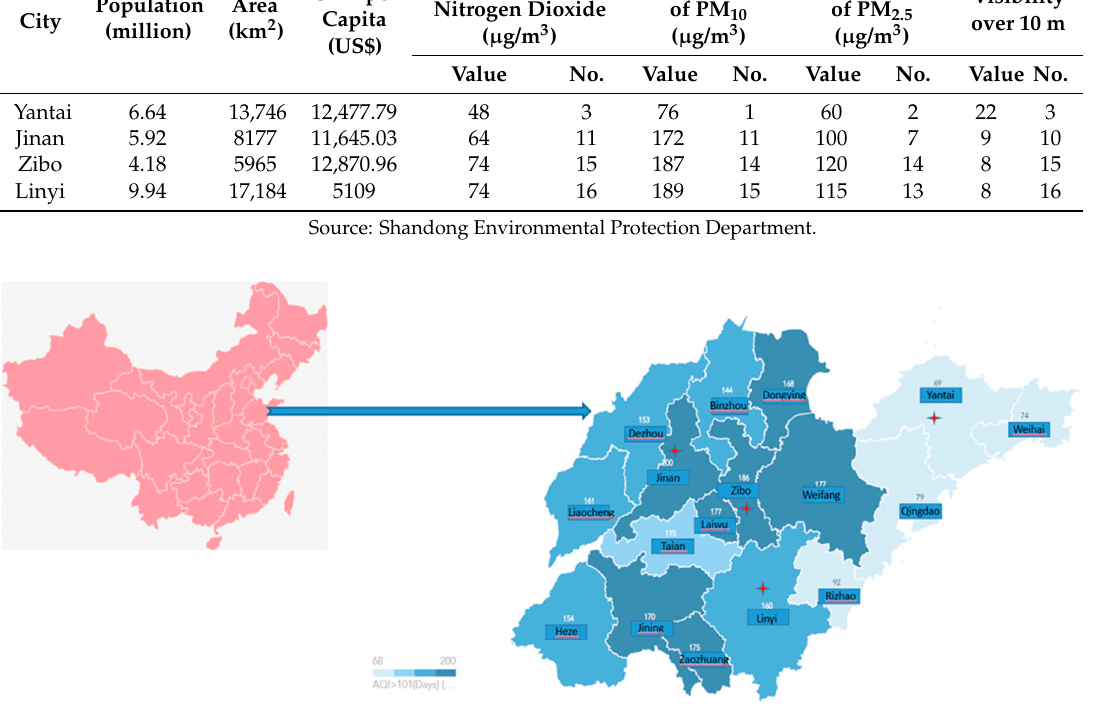
Figure 1. Air Quality Index > 101 days in Shandong Figure 1 . Air Quality Index > 101 days in Shandong (2014).